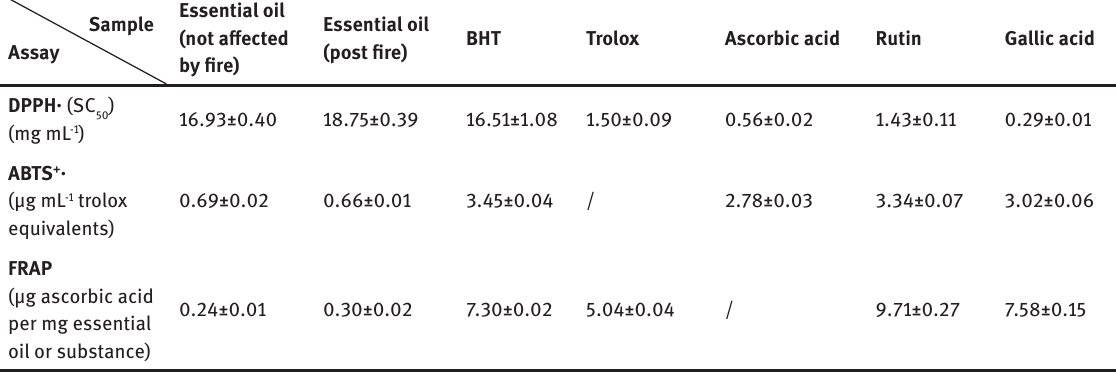
Table 3: Antioxidant activity of fruit essential oil of S. rigidum from non affected by fire and post fire area (DPPH., ABTS + . and FRAP).